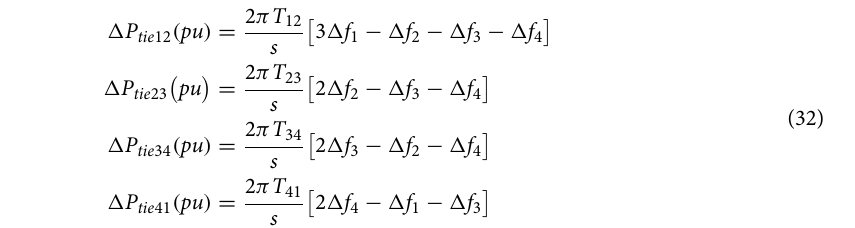
Figure 2. Four areas interconnected power system with area control